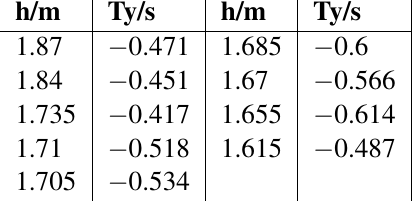
Table 6 The initial phases of subjects with different heights when walking at a speed of 0.8